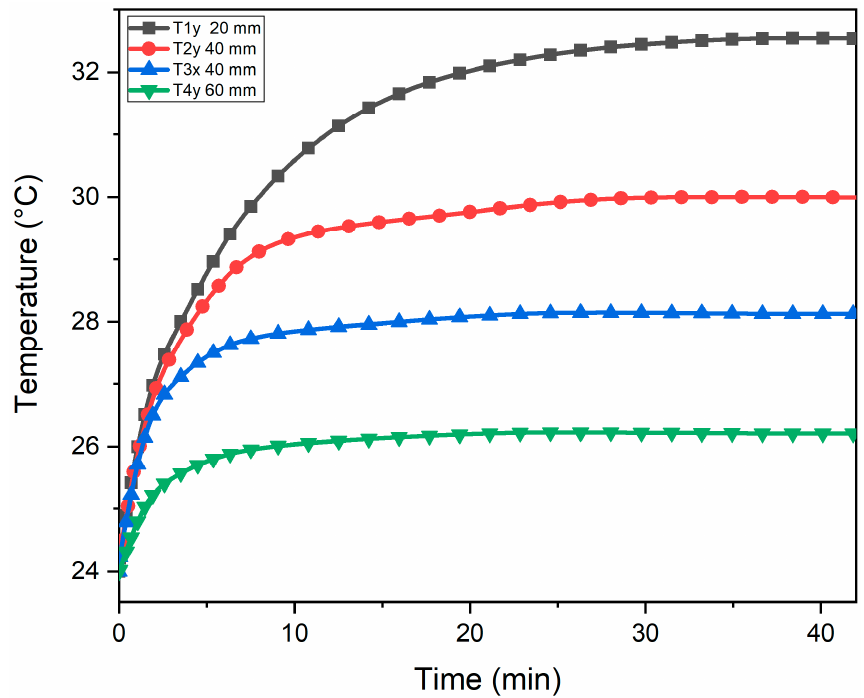
Figure 9. Temperature profile along the x- and y-axis for crossflow configuration with 30 W power input.